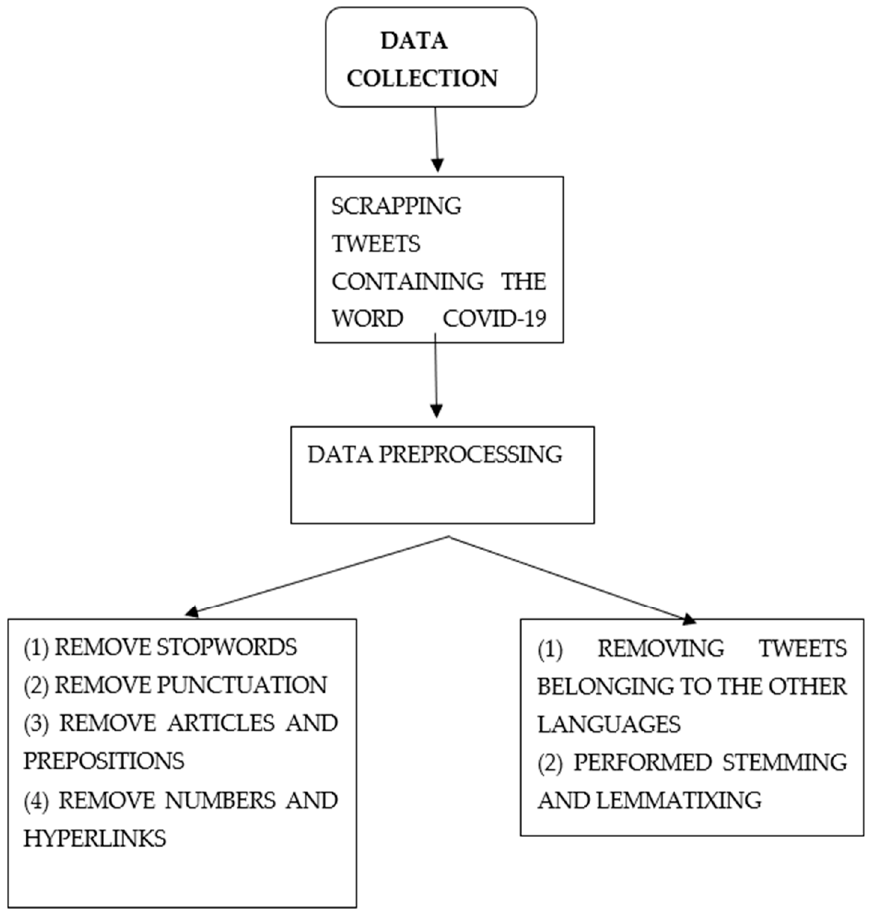
Figure 1. Data collection and data pre-processing.